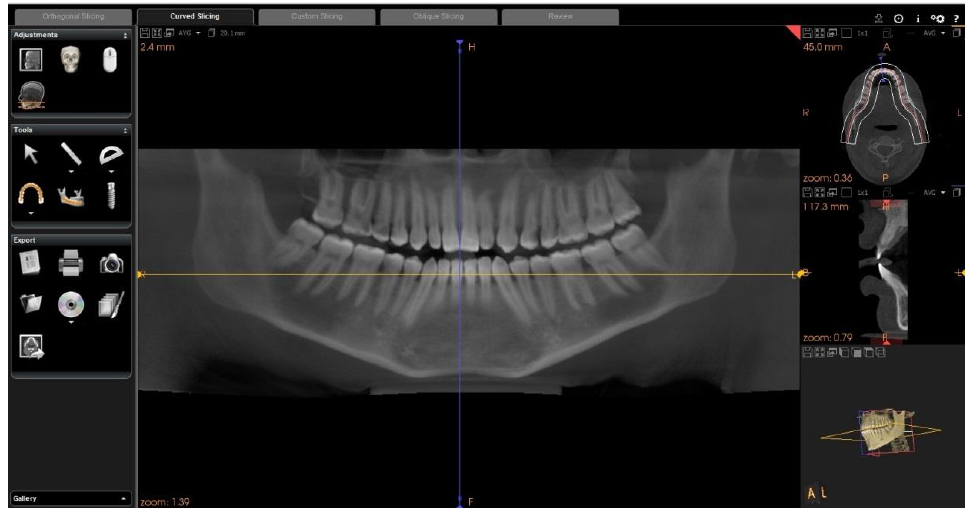
Figure 1: Site assessment